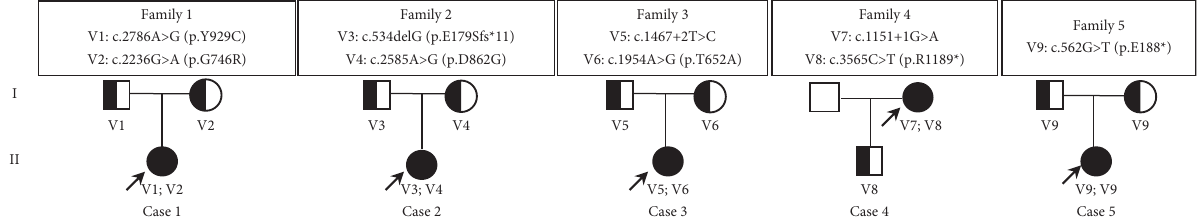
Figure 1: Pedigrees of Chinese families with LCA6 harboring pathogenic RPGRIP1 variants. The proband is indicated by an arrow. The squares and circles indicate men and women, respectively. The black solid square or circle represents the affected individual. The half black solid circle or square represents the variation carrier. V: variant. Table 1: Clinical features of patients with